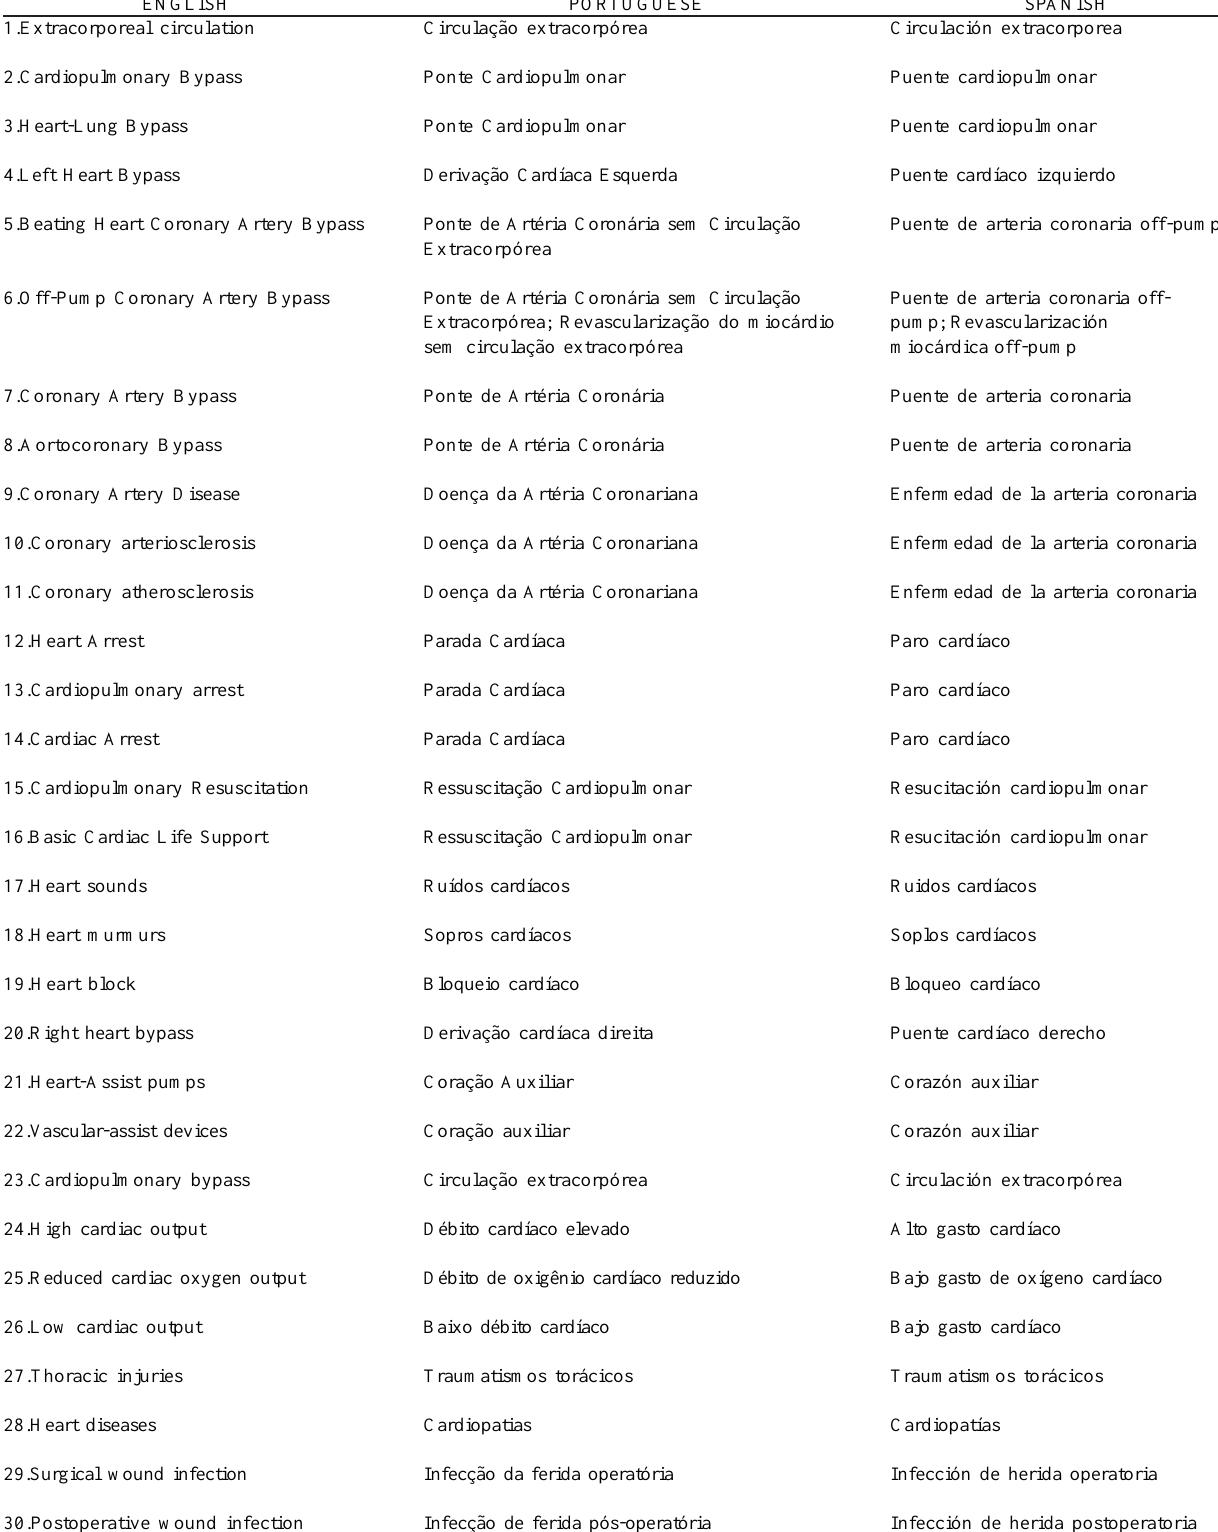
Table 2. English, Portuguese, and Spanish main cardiological terms in common